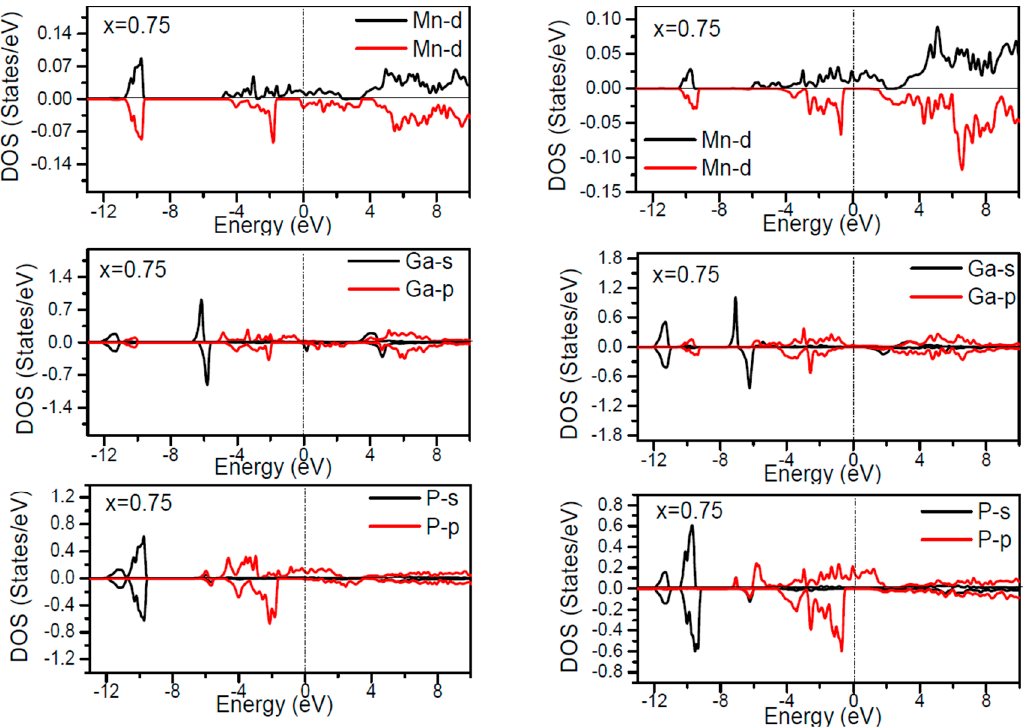
Figure 6. Computed partial DOS of spin polarized contributions from Ga-s,p, As-s,p, and Mn-d states in the Ga 1 − x MnP ( x = 0.75) alloys for spin up and spin down. The left panel indicates the GGA calculations and right panel denotes the GGA + U calculations. The vertical dash line denotes the Fermi level.